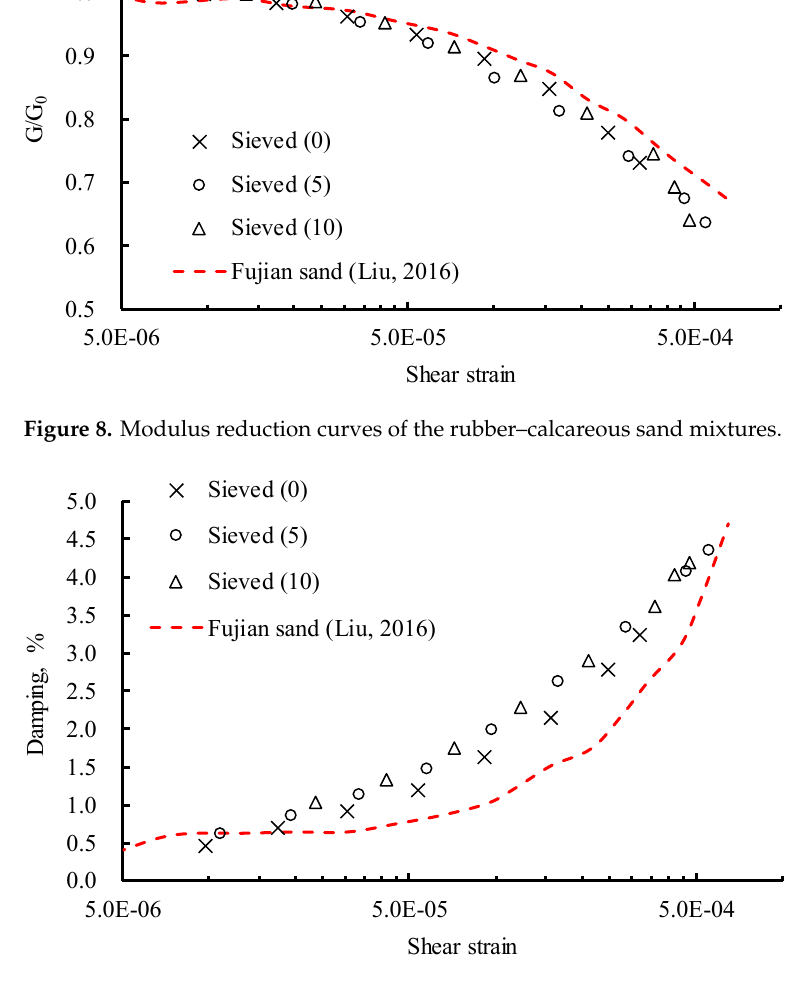
Figure 9. Damping curves of the rubber–calcareous sand mixtures.